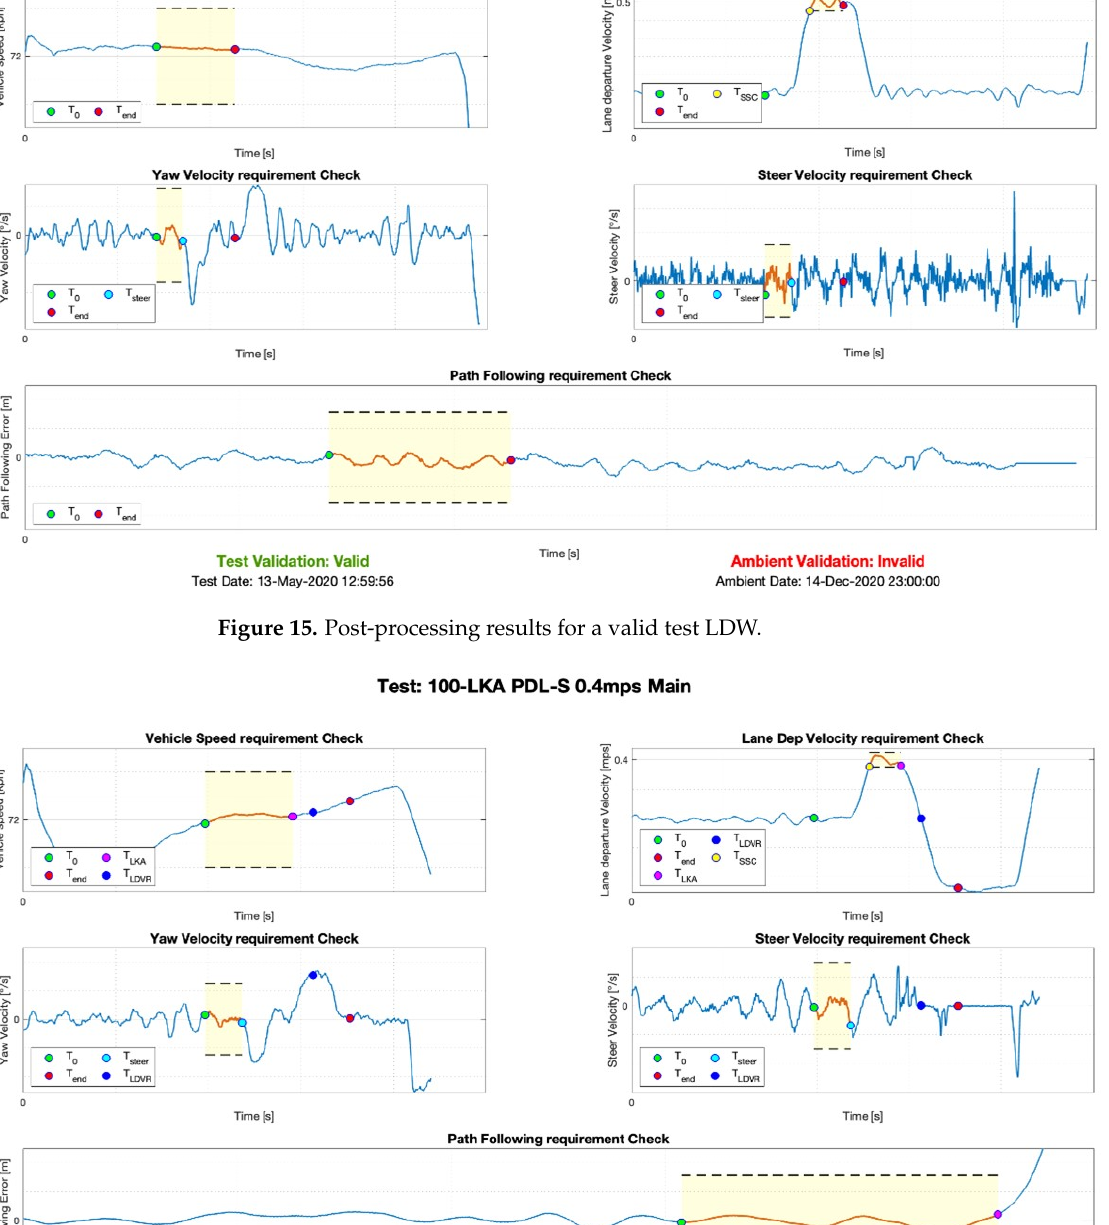
Figure 17. Post-processing results for a valid test ELK. In Figures 15–17, the realized algorithm automatically shows all the useful infor- mation extracted from the data saved for the selected LLS test. The results, output of the proposed code, are distributed in a single figure that contains five subplots, representing the velocity profiles, the lane departure velocity, the yaw angular velocity, the steering angular velocity, and the path-following error. The lane-departure velocity is the speed at which the system moves away from the lane. This variable is not directly obtainable from the data of the inertial system. Still, it is necessary to identify it from an act of rigid motion, considering the speed profile in the reference point, which, for these tests, was positioned at the outermost point of the car or the front bumper. In particular, this point will vary between the right or left side